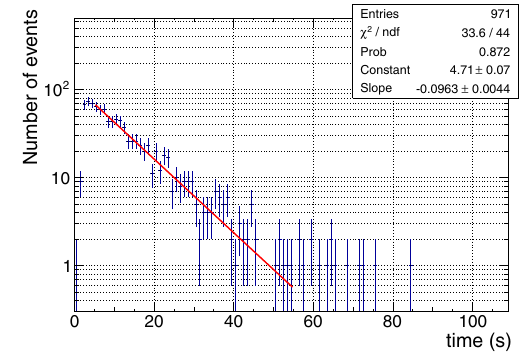
Fig. 5 Distribution of the time intervals between consecutive events occurredduringrunn.1220performedat (cid:2) T ∼= 6 . 5 ◦ CusingtheAmBe source